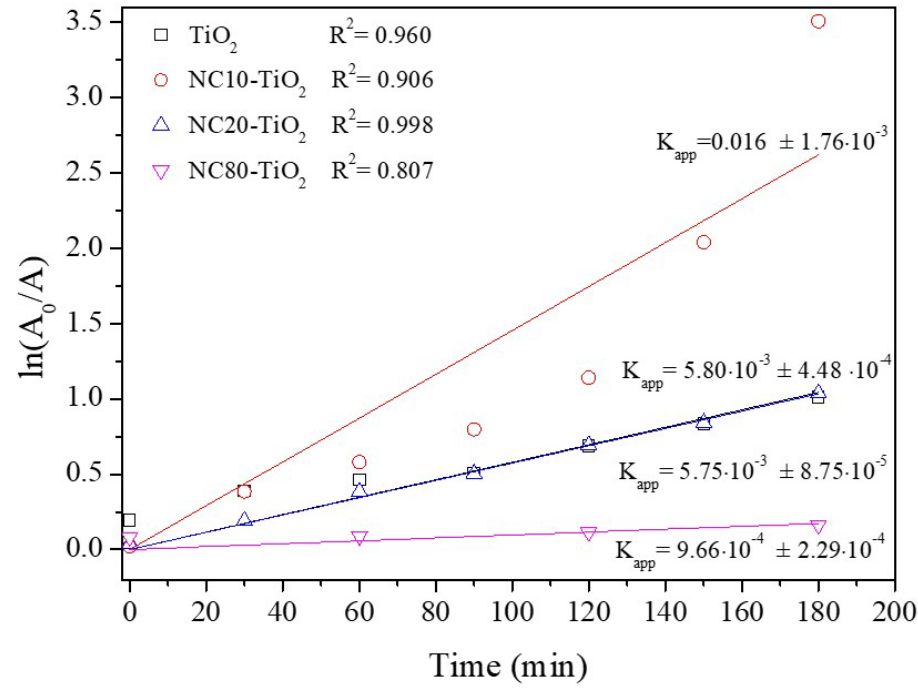
Figure 6. Kinetics of methyl orange photodegradation using NC–TiO 2 nanocomposites.